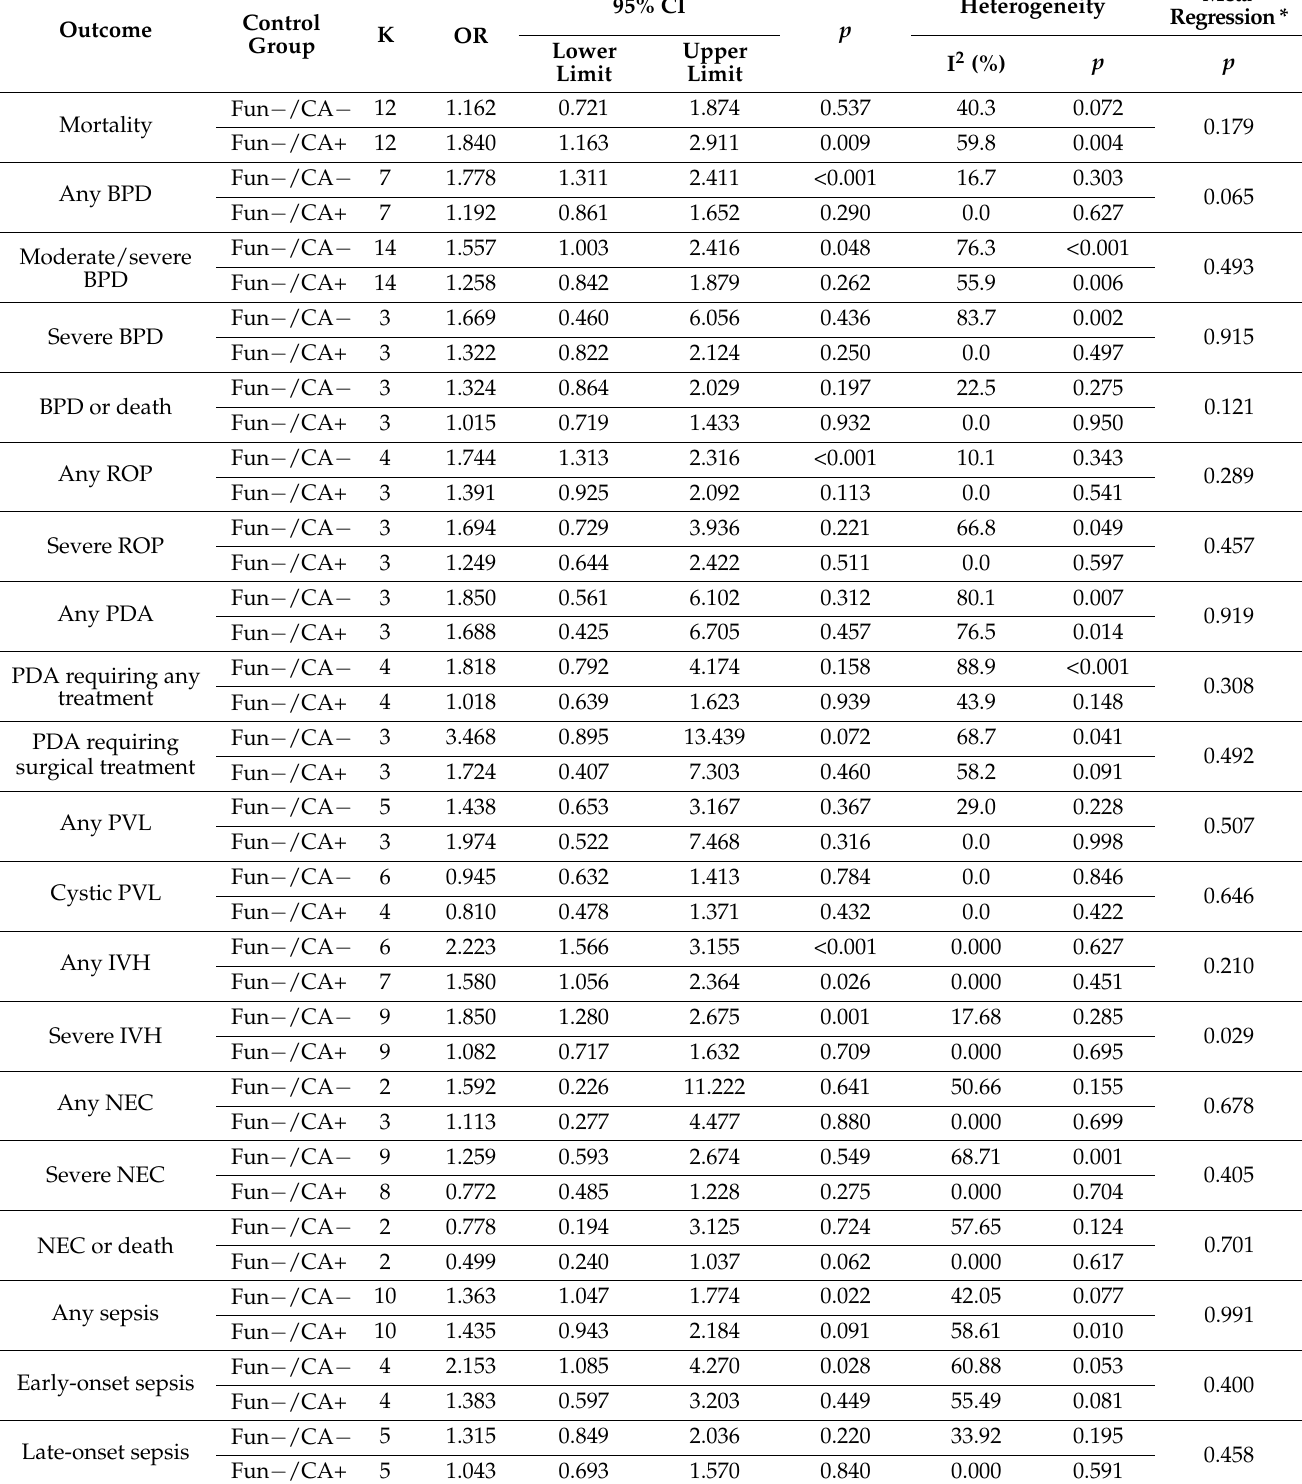
Table 2. Meta-analyses comparing infants with funisitis vs. infants who had neither funisitis nor chorioamnionitis (Fun − /CA − ) or infants without funisitis but with chorioamnionitis (Fun −